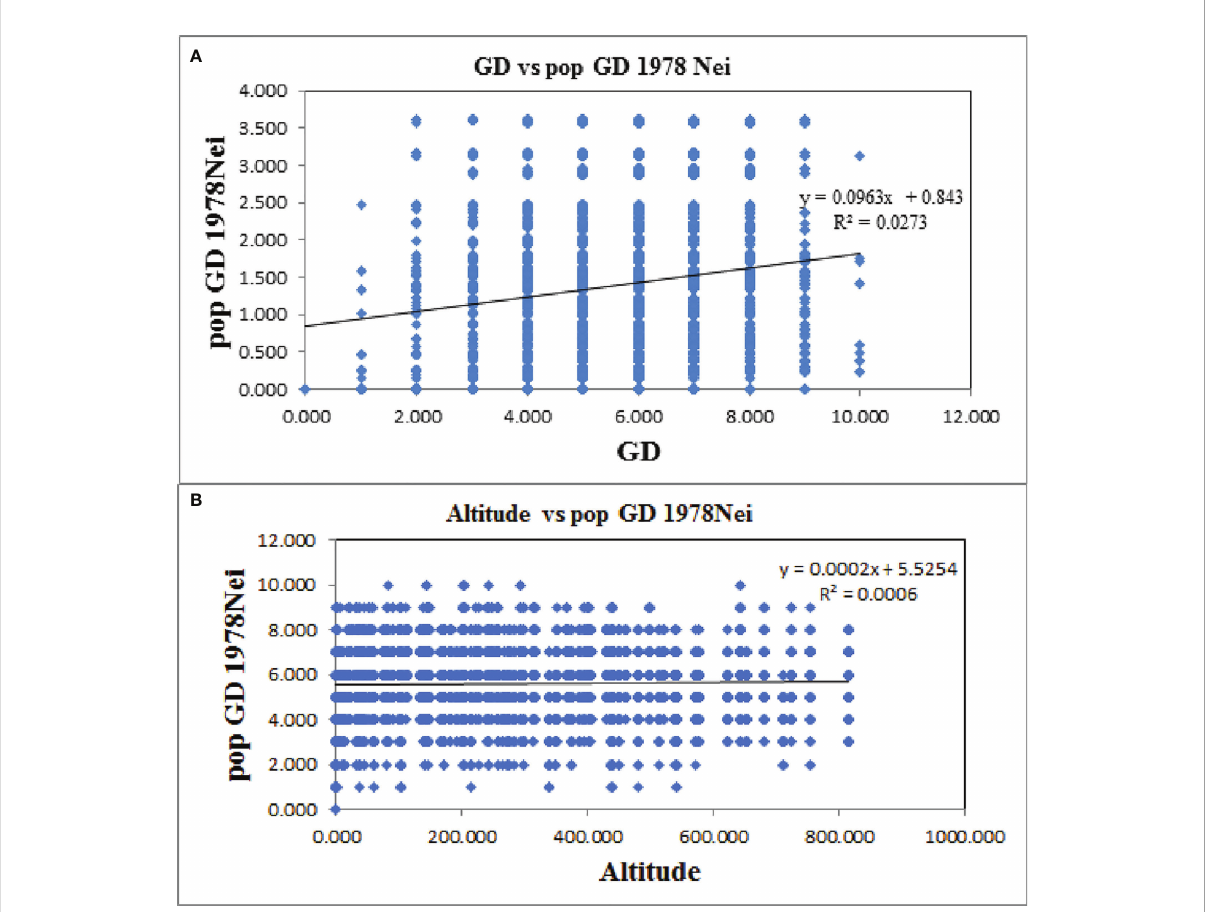
FIGURE 9 Mantel test between genetic distance (A) and geographic distance (B) of Ch. utilis based on EST-SSR